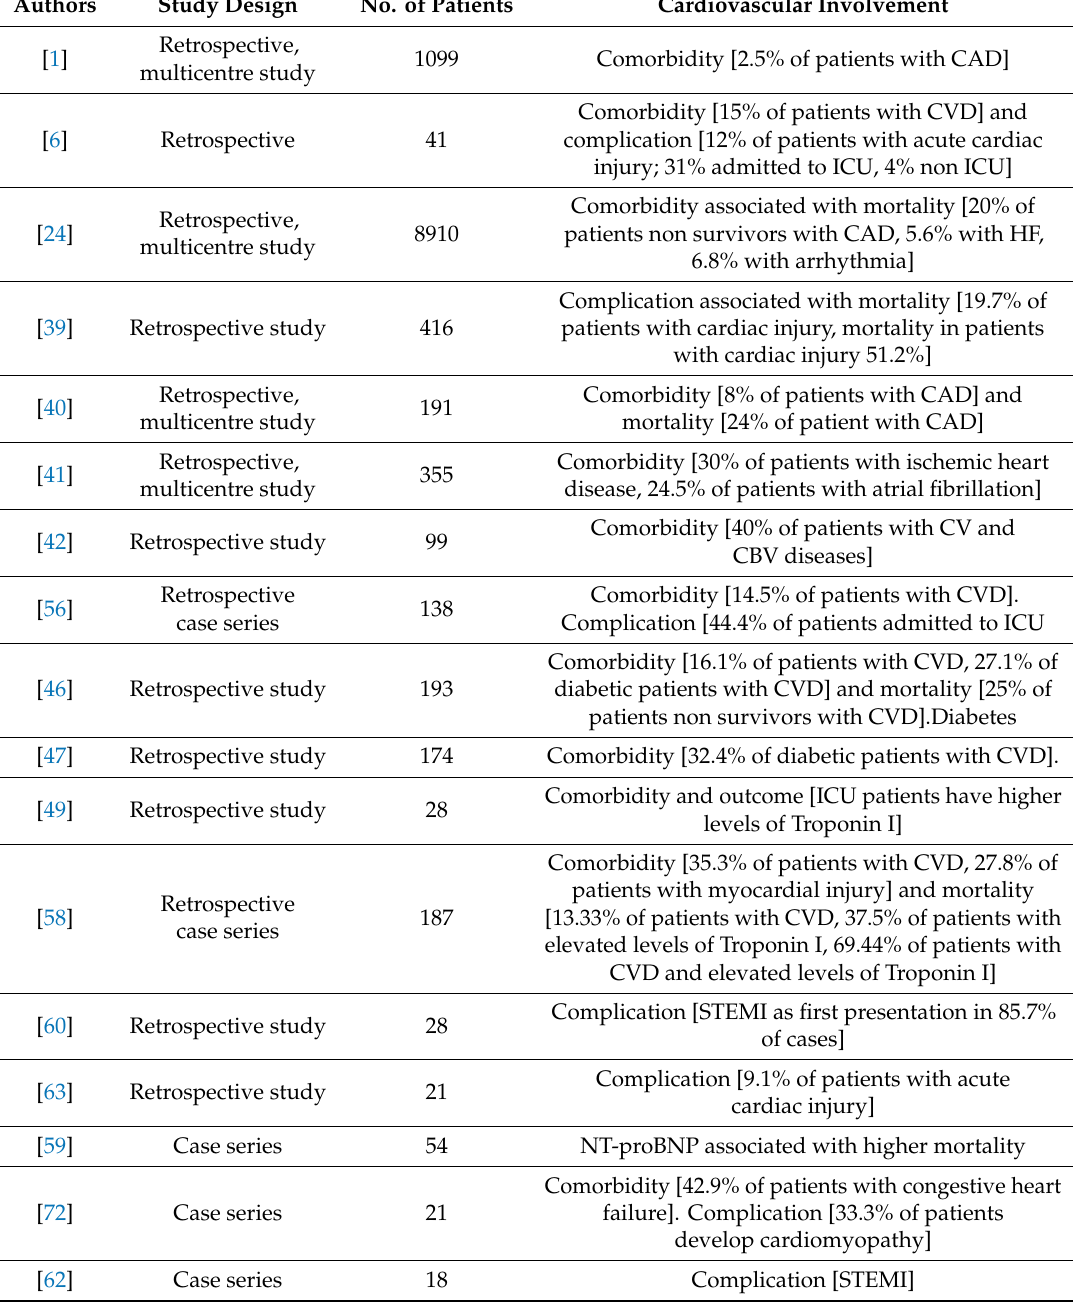
Table 1. Studies showing a relationship between SARS-CoV-2 infection and cardiovascular disease.